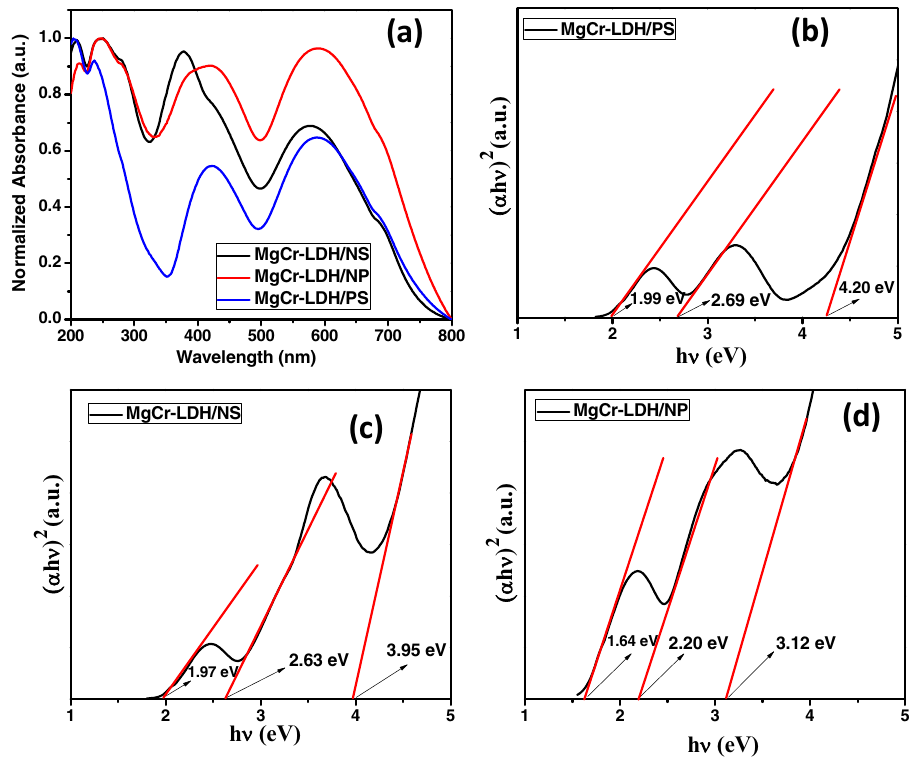
Figure 12. ( a ) Normalized UV–Vis DRS spectra of MgCr-LDH/PS, MgCr-LDH/NS, and MgCr-LDH/NP. ( b – d ) Band gap energy plot of MgCr-LDH/PS, MgCr-LDH/NS, and MgCr-LDH/NP as derived from Kubelka– Munk equation through Tauc